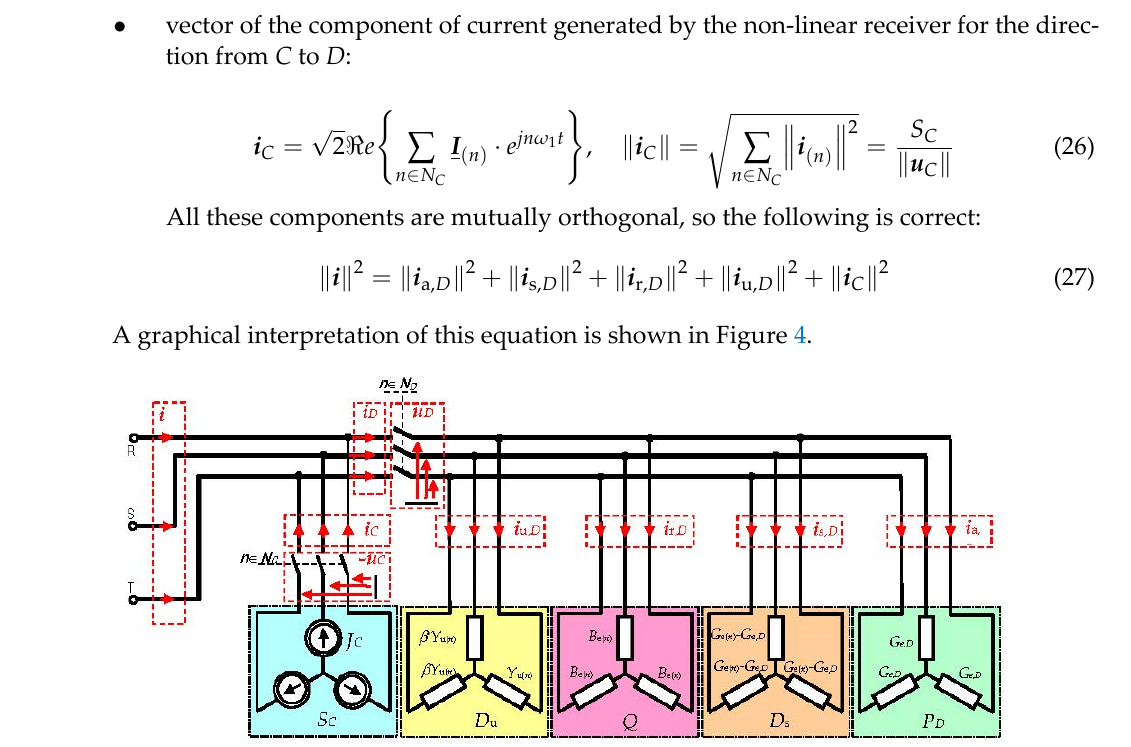
Figure 4. Graphical interpretation of Equation (27).